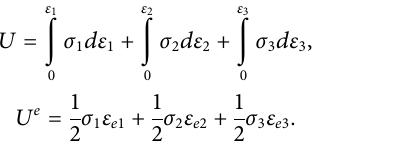
different con fi ning pressures. The macroscopic shear fracture surface can be seen when the failure of the rock specimen occurs.